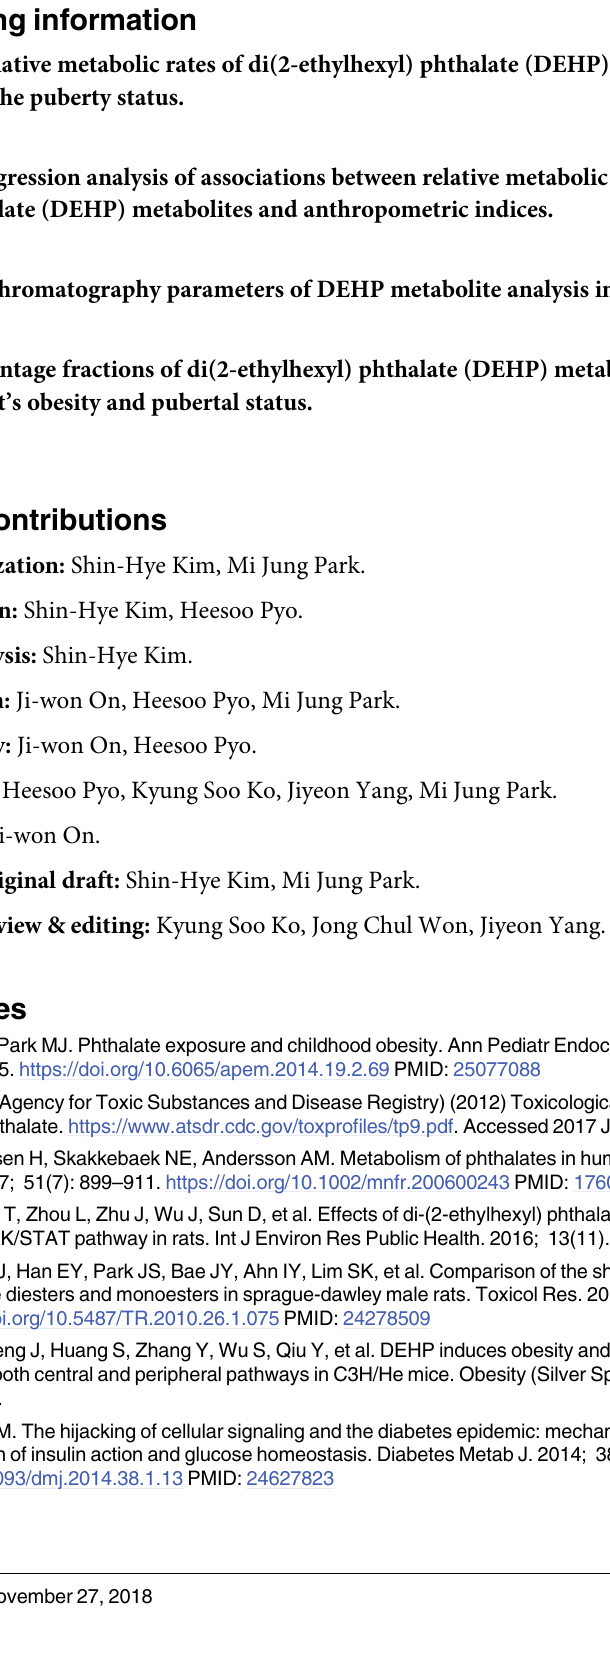
S1 Table. Relative metabolic rates of di(2-ethylhexyl) phthalate (DEHP) metabolites by obesity and the puberty status. S2 Table. Regression analysis of associations between relative metabolic rates of di(2-ethyl- hexyl) phthalate (DEHP) metabolites and anthropometric indices. S1 Fig. Gas chromatography parameters of DEHP metabolite analysis in urine samples. (TIF) S2 Fig. Percentage fractions of di(2-ethylhexyl) phthalate (DEHP) metabolites according to the subject’s obesity and pubertal